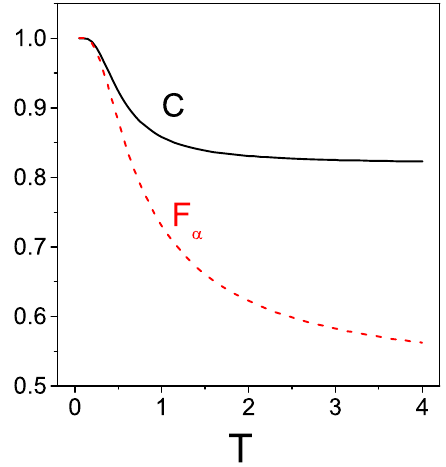
Fig. 5 The decoherence of quantum coherence C and quantum Fisher information F α areillustratedbytheblacklineandreddashlinerespec- tively. The parameters of α = π/ 2 and ω = 1 are chosen